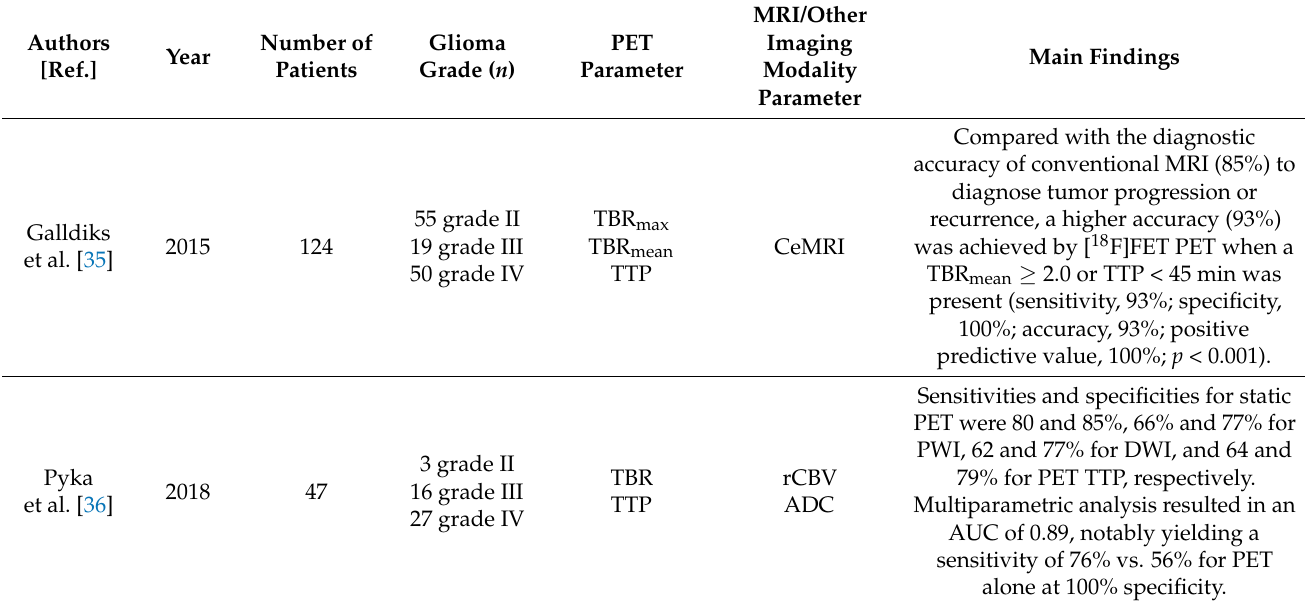
Table 1. Summary of the described studies regarding [ 18 F]FET PET in glioma recurrence/differential